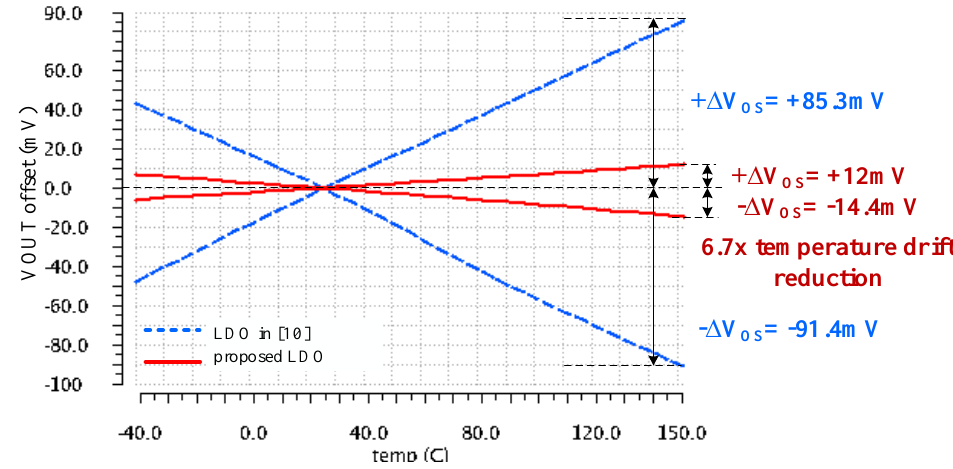
Figure 13. Variation with temperature of the worst-case output voltage errors for the LDO reported in [10] (dotted blue lines) and the LDO proposed here, shown in Figure 3 (continuous red lines). For both LDOs, the operating conditions were VIN = 1.5 V, IL = 1 mA, and CL = 100 pF, and the output voltage was trimmed by adjusting the LDO reference so that Vout = 1 V at +25 °C.